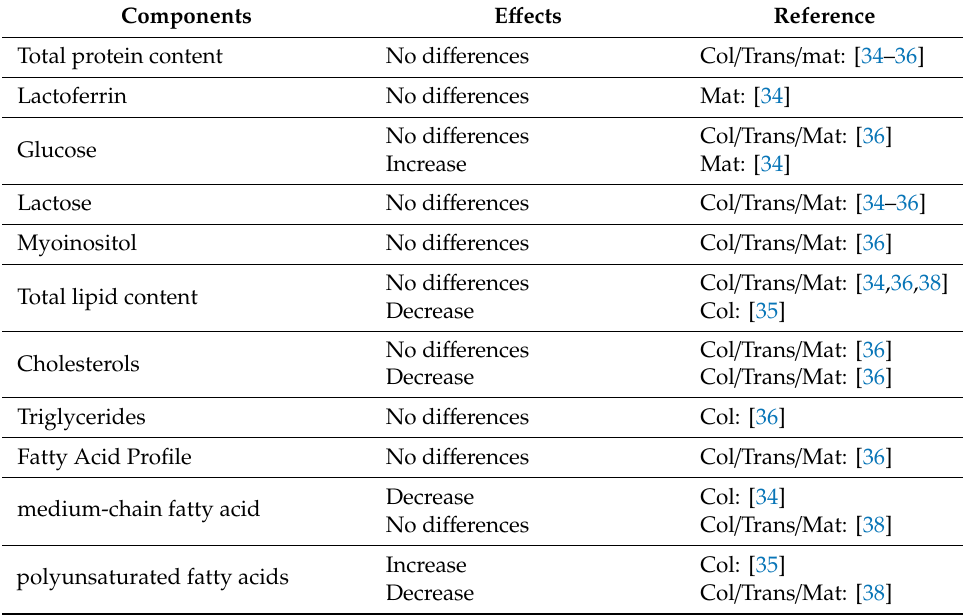
Table 4. Results of the di ff erent studies included in the survey regarding IDDM and HM.